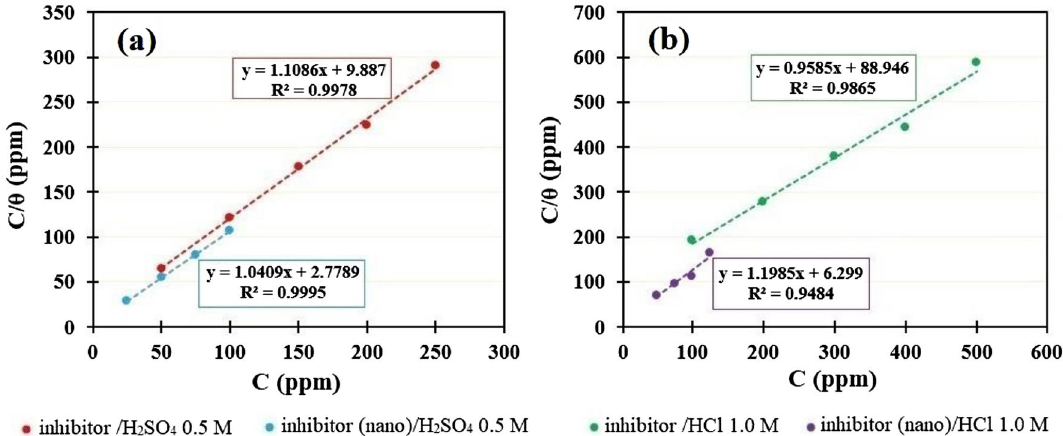
Figure 8. Langmuir adsorption isotherm of the inhibitor determined by Tafel polarization data for st-37 in ( a ) 0.5 M H 2 SO 4 , and ( b ) 1.0 M HCl solutions at 25 ± 1 °C. Sample